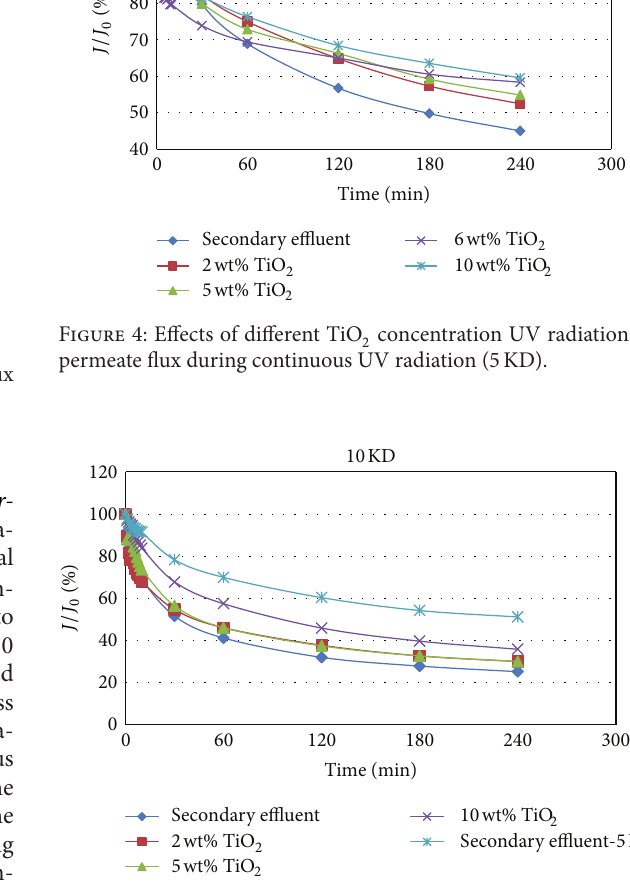
Figure 5: Effects of different TiO 2 concentration UV radiation on permeate flux during continuous UV radiation (10KD).